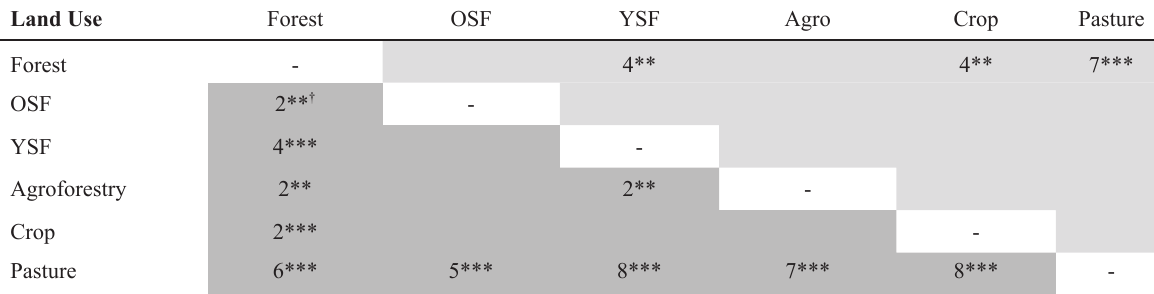
Multiple pairwise comparisons of community composition of FMA within trap culture (upper panel) and directly field sampling (lower panel).